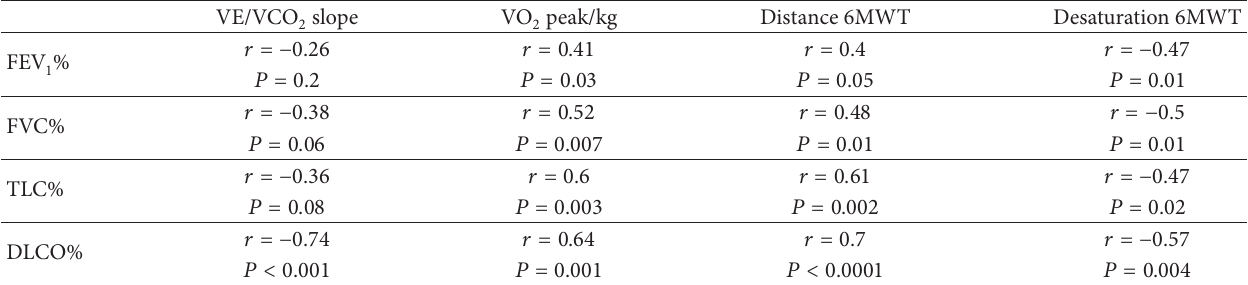
Table 5: Relationships between the variables of both exercise tests and pulmonary function tests in the study population by Spearman’s rank correlation coefficient. 𝑃 value < 0.05 is considered significant.